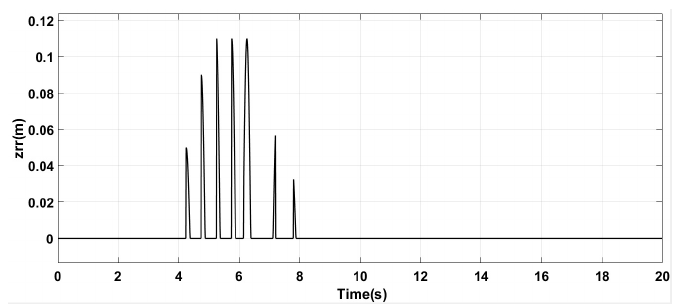
Figure 5. Rear Road Disturbance.